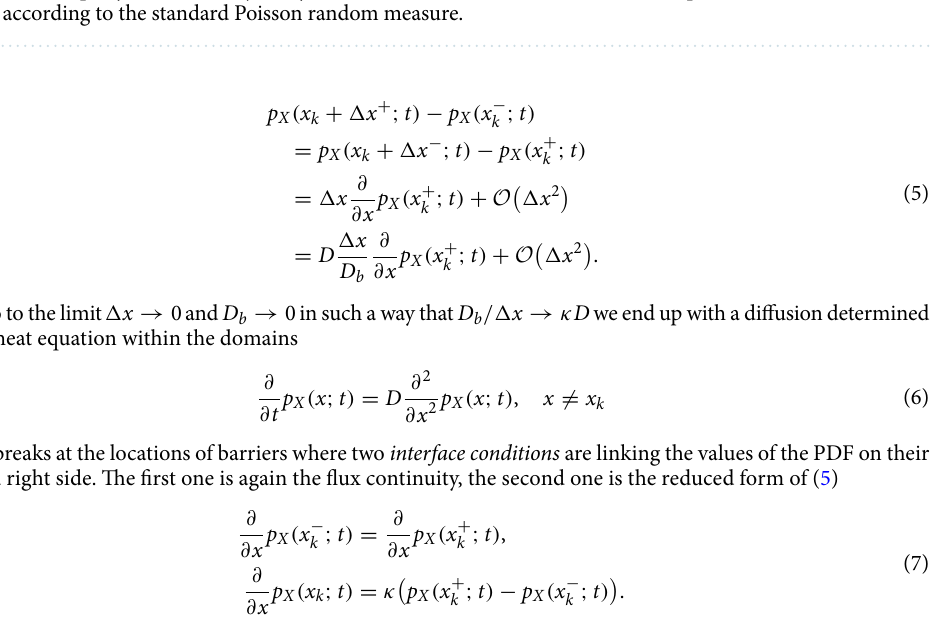
1 / 50, D 1 and discretization step (cid:31) t = =